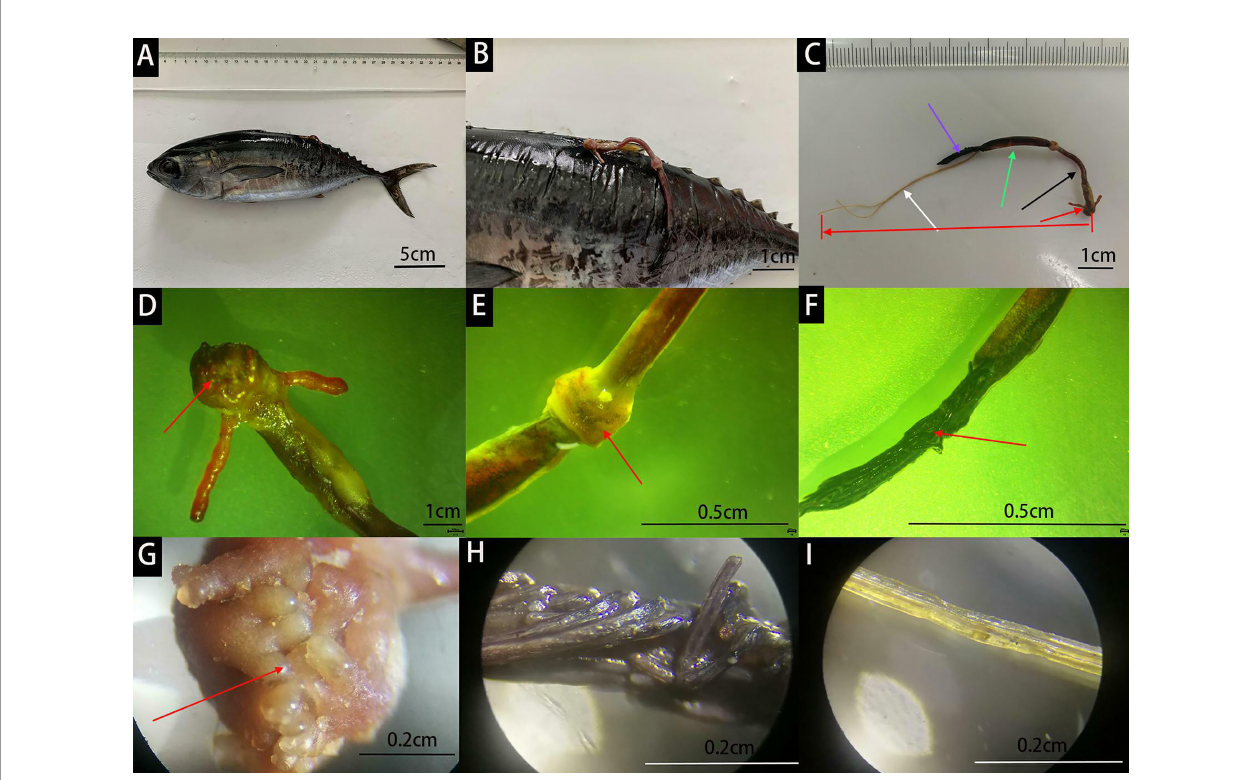
FIGURE 2 | Infected yellow fi n tuna (A) . Parasites on the posterior dorsal fi n (B) . The red arrow represents the cephalothorax, the black arrow represents the neck, the green arrow represents the trunk, the purple arrow represents the abdomen, and the white arrow represents the egg belts (C) . The head and tail of the red arrow at the bottom of the fi gure represent the starting and ending positions of the parasite (C) . Mastoid process on the cephalothorax (D, G) . The node between the neck and trunk (E) Abdomen (F, H) . Yellow egg belts (I)